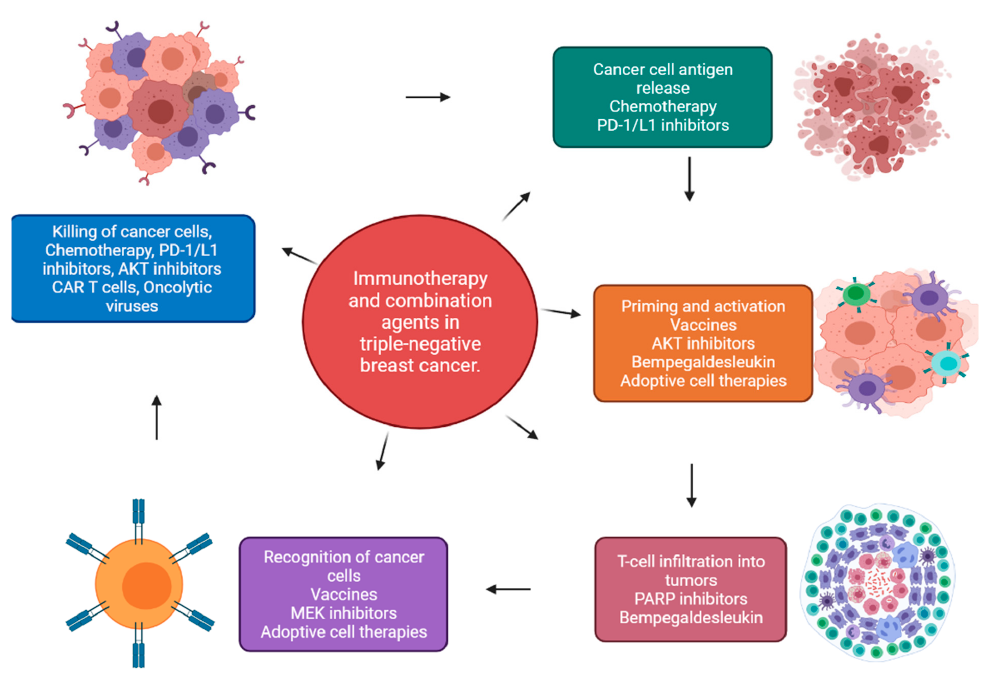
Figure 6. Immunotherapy agents in triple-negative breast cancer.